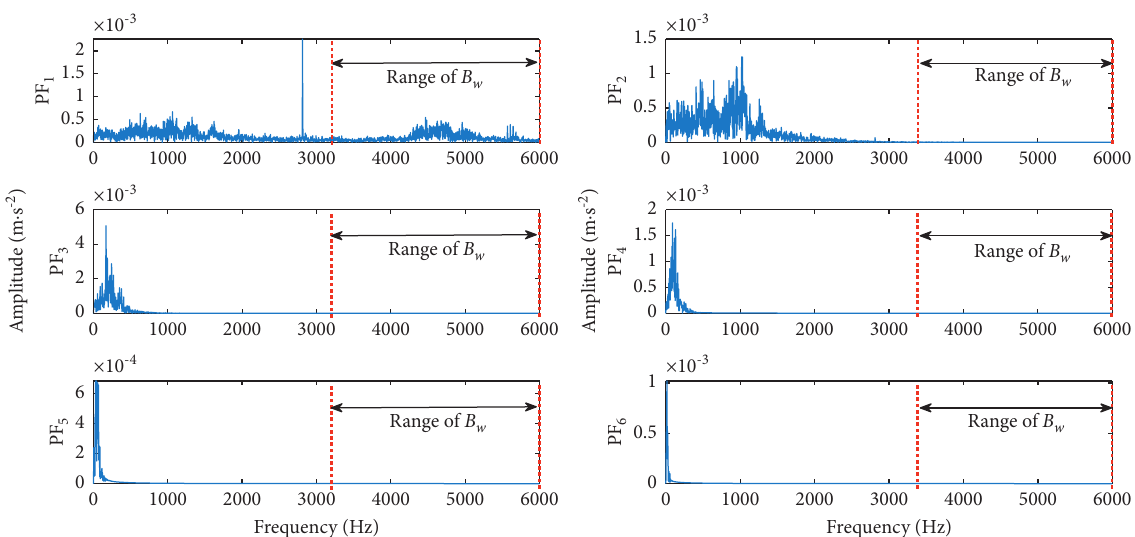
Figure 12: Calculated PF components with the ELMD algorithm for the experimental dataset.